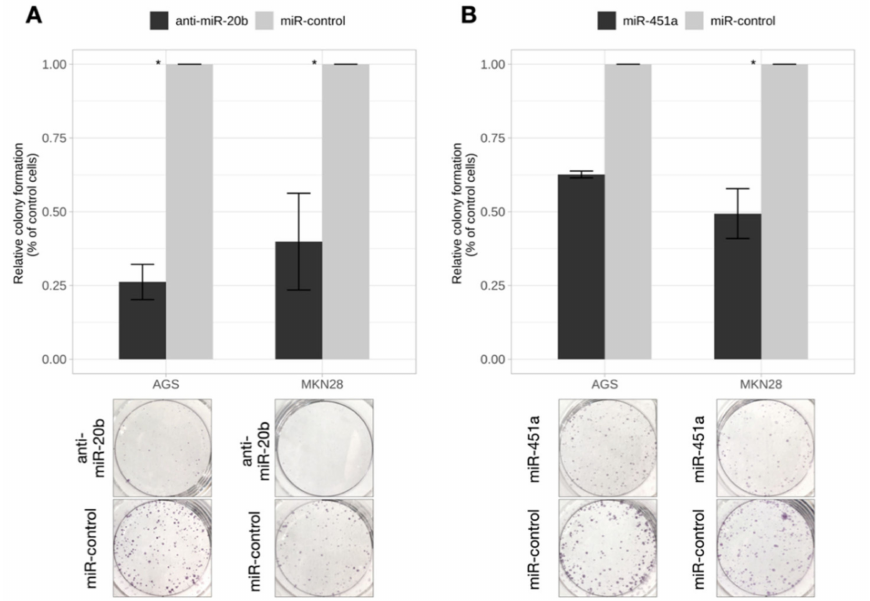
Figure 5. Exogenously altered expression of miR-20b and miR-451a a ff ected colony formation. ( A ) Relative colony formation (of control cells) in AGS and MKN28 cells after inhibition of miR-20b. Formation of colonies reduced significantly in both AGS and MKN28 cell cultures compared to miR-control (* p < 0.05); ( B ) Relative colony formation (of control cells) in AGS and MKN28 cells after increased expression of miR-451a. Formation of colonies reduced significantly in both AGS and MKN28 cell cultures compared to miR-control (* p < 0.05). Representative pictures of fixed colonies are presented at the bottom of a figure. Data from five independent